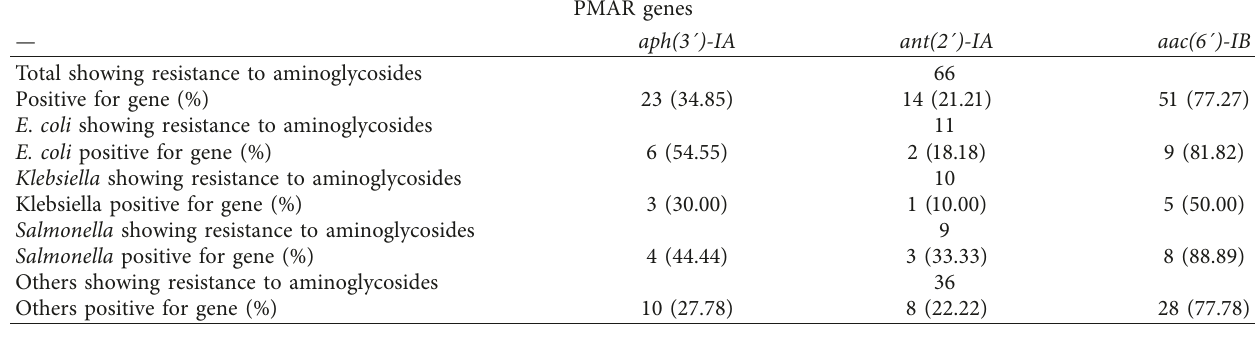
Table 11: Prevalence of PMAR genes detected by PCR.